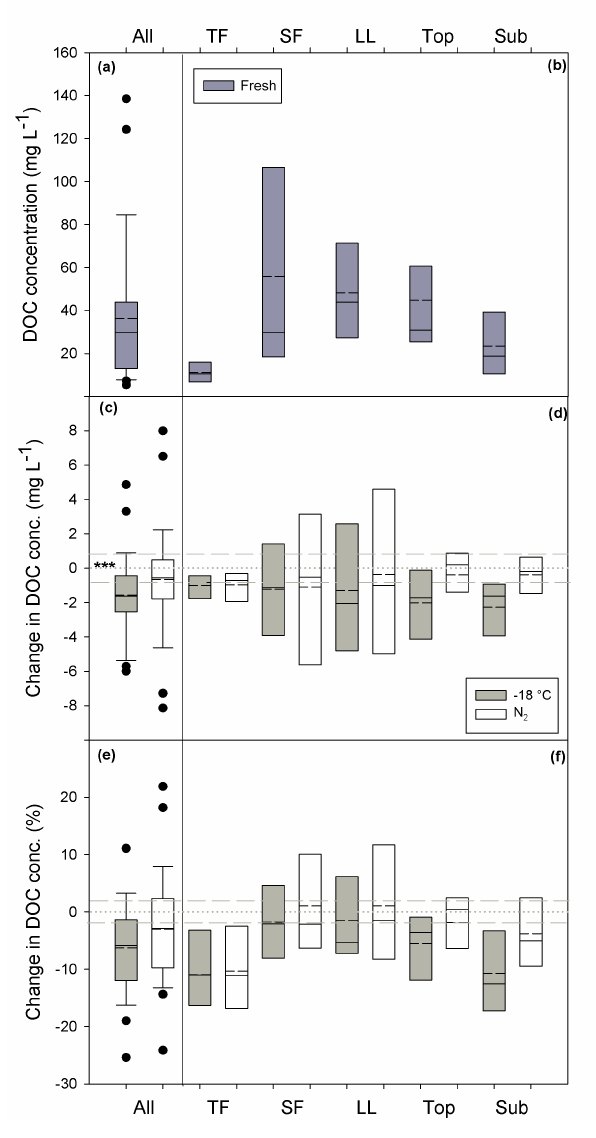
Figure 1. Absolute DOC concentrations (measured in fresh sam- ples) and changes in DOC concentrations after freezing ( − 18 ◦ C) and fast-freezing with liquid nitrogen; (a, c, e) all samples ( n = 27); (b, d, f) ordered by sample type (throughfall (TF) n = 6, stem- flow (SF) n = 5, litter leachate (LL) n = 5, top soil solution (Top) n = 6, sub-soil solution (Sub) n = 5); gray dashed line: analytical reproducibility; ∗∗∗ significant changes (linear mixed models (lme), p< 0 . 05); boxplots: solid line: median, dashed line: mean.